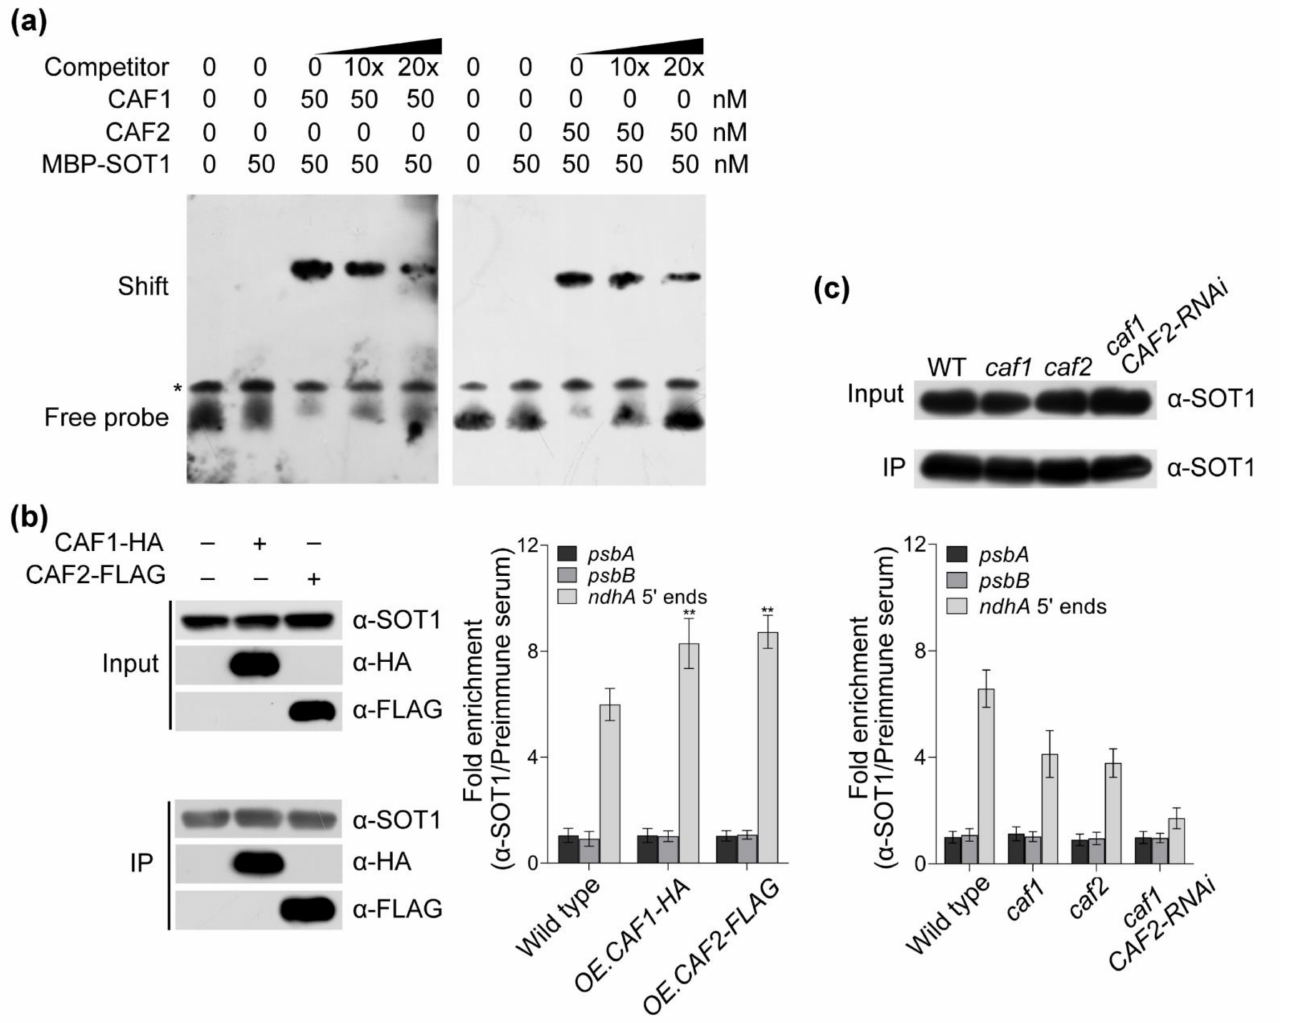
Figure 6. CAF1 and CAF2 promote the binding of SOT1 to the 5 (cid:48) end of ndhA transcripts. ( a ) Electrophoretic mobility shift assay (EMSA) showing the positive effect of CAF1 and CAF2 on the binding of SOT1 to the 5 (cid:48) end of ndhA transcripts. The predicted binding sequence (UGGCUGAUAUUA) of SOT1 on ndhA transcripts was synthesized and labeled with biotin. Increasing concentrations of recombinant CAF1 or CAF2 proteins were incubated with 10 nM biotin-labeled probe and the MBP-SOT1 protein. The competitor used in the competition experiments was an unlabeled probe corresponding to the predicted binding sequence of SOT1 on the ndhA transcripts. The asterisk indicates an unspecific band. Three independent experiments were performed, and one representative experiment is shown. ( b ) Overexpressing CAF proteins promoting the binding of SOT1 to the 5 (cid:48) end of ndhA transcripts in vivo. The HA-tagged CAF1 and FLAG-tagged CAF2 were overexpressed (OE) in protoplasts isolated from 12-day-old seedlings. Chloroplasts were harvested from the transfected protoplasts. Protein complexes were immunoprecipitated (IP) using an α -SOT1 antibody. (Left) Immunoblot analysis of the protein presence in chloroplast extract as immunoprecipitated using an α -SOT1 antibody. The immunoblot results showed a comparable enrichment of SOT1 protein in samples. (Right) The relative levels of psbA , psbB , and ndhA 5 (cid:48) -end mRNAs in the α -SOT1 immunoprecipitated complexes were determined using a qPCR. Student’s t -test was carried out to determine the significance of the fold enrichments of SOT1 on ndhA 5’-end RNAs between WT and OE.CAF protoplast. ** indicates a significant difference at p < 0.01. Mean values ± SD of the triplicate replicates are shown. ( c ) The loss of CAF proteins leads to the decreased association of SOT1 with the 5 (cid:48) end of ndhA transcripts. The stromal extracts from wild-type, caf1 , caf2 , and caf1 CAF2 -interference (RNAi) plants were immunoprecipitated with an α -SOT1 antibody. (Upper) Immunoblot analysis of the protein presence in the chloroplast extract, as immunoprecipitated using an α -SOT1 antibody. (Lower) The relative levels of psbA , psbB , and ndhA 5 (cid:48) -end mRNAs in the α -SOT1 immunoprecipitated complexes were determined using qPCR. Mean values ± SD of the triplicate replicates are